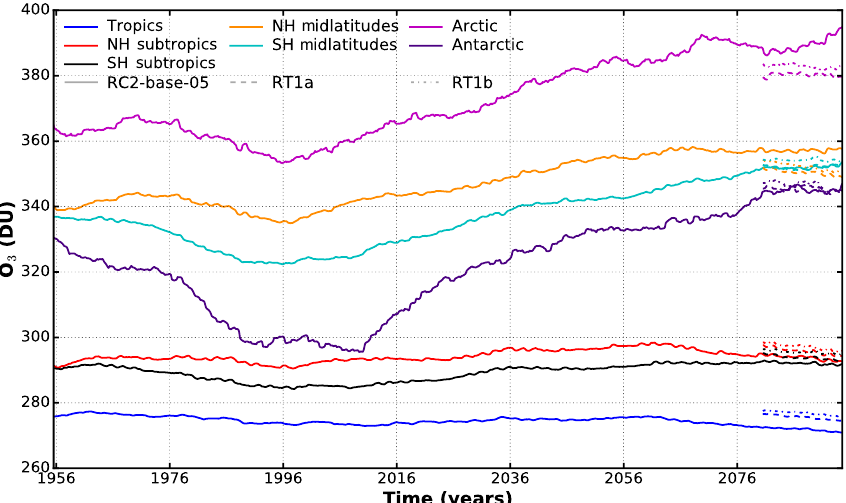
Figure 10. Zonal mean ozone trend from RC2-base-05 (1950–2100) and RT1a / RT1b (2080–2100). Smoothed with moving average box window 11 years.